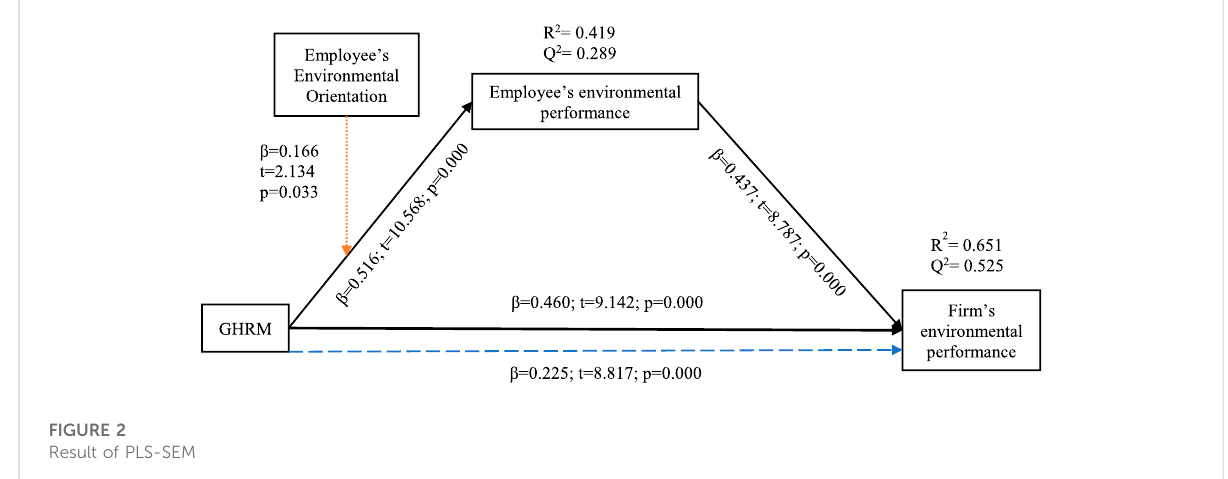
FIGURE 2 Result of